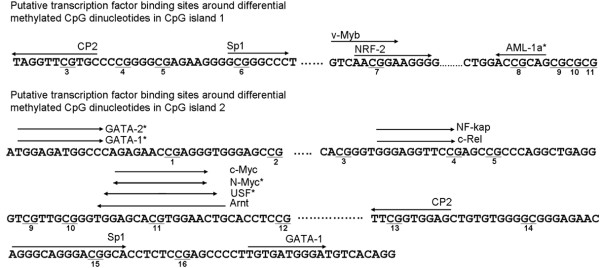
Putative transcription factors (TFs) binding sites around differentially methylated CpG dinucleotides. The sequence surrounding specific CpG sites are shown in the picture, differentially methylated and necessary neighbouring CpG dinucleotides are underline highlighted, the numbers below tags the relative position of each CpG sites in CpG island. The direction of the arrows above the sequence indicate the binding direction of TFs, arrow coved sequences are the binding consensus for each TFs tagged around the arrows. The binding pattern of TFs was analyzed by TFSEARCH programme Version 1.3 (Threshold score = 85.0), score>90.0 are asterisked.